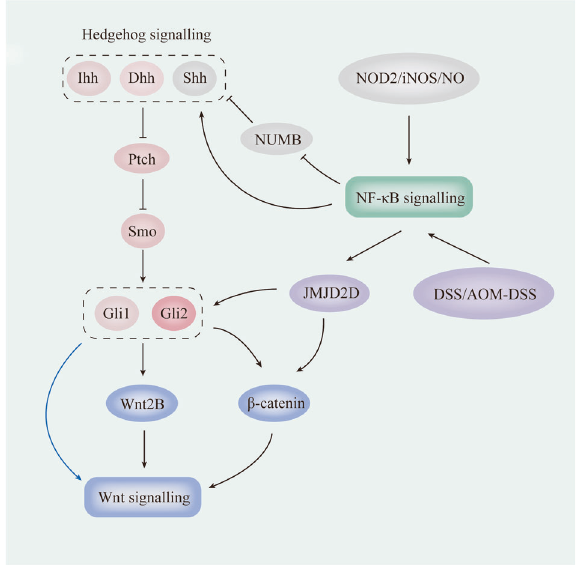
Fig. 2 Crosstalk between Hedgehog and other pathways in the intestinal tract. β -catenin is a target gene of Hh/Gli2 signalling. Hh signalling can enhance Wnt signalling by inducing the expression of β -catenin in the colon during IBD and CAC. Epithelial Ihh and Shh upregulate the expression of Wnt2B in intestinal mesenchymal cells during chronic intestinal in fl ammation. The subepithelial Gli1- positive mesenchymal cells express high levels of Wnt2B. Dhh- activated Hh signalling positively regulates epithelial cell-produced Wnt2B expression following IEC injury and regeneration. Gli1- expressing mesenchymal cells serve as a reserve Wnt source during recovery from DSS-induced colitis in mice, thereby enhancing Wnt signalling. Shh is a target gene of NK- κ B and can be induced by the activation of NK- κ B in in fl amed intestinal epithelial cells. NK- κ B mediates NOD2-iNOS/NO-NUMB-mediated Shh signalling activa- tion, which plays a role in modulating in fl ammatory responses in IBD. TNF-a/NF- κ B signalling promotes the activation of Hh/Gli1/ Gli2 signalling in DSS- or AOM/DSS-induced colitis. Arrows and blunt ends indicate activation and inhibition, respectively. The blue arrows indicate a special condition where Gli1 is overexpressed in mesenchymal cells. NOD2 the nucleotide-binding oligomerization domain 2, iNOS inducible nitric-oxide synthase, NO nitric oxide, NF- κ B nuclear factor-kappaB, Ihh Indian hedgehog, Dhh Desert hedge- hog, Shh Sonic hedgehog, Ptch Patched, Smo Smoothened, Gli1 Glioma-associated oncogene 1, Gli2 Glioma-associated oncogene